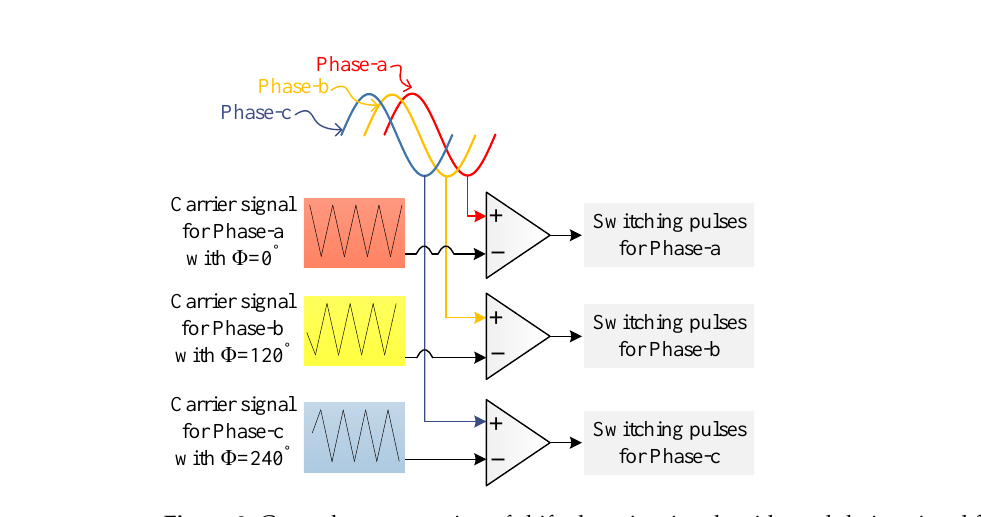
Figure 8. General representation of shifted carrier signals with modulating signal for three-phase.